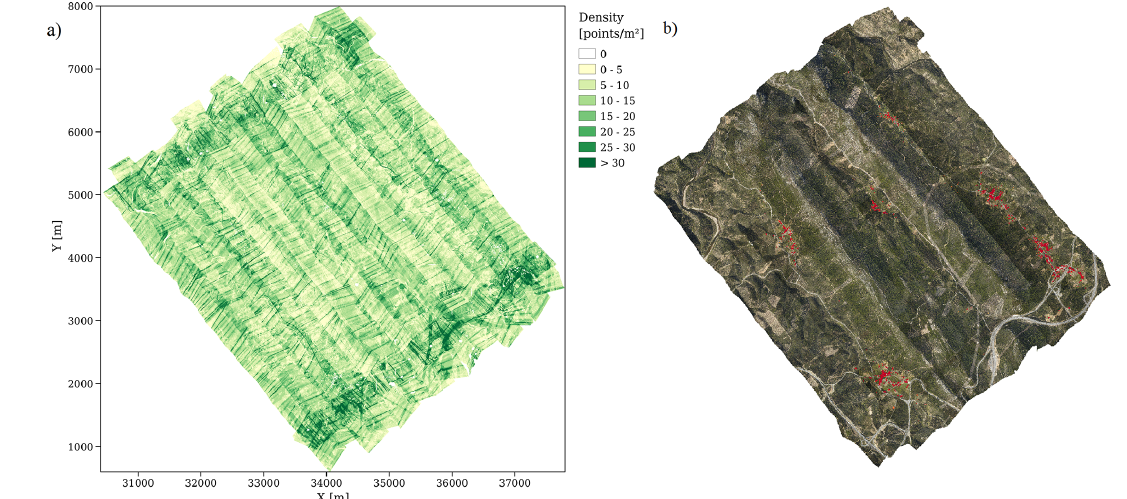
Figure 1. Lidar aerial survey and orthophoto: (a) ground -class point distribution; (b) orthophoto (houses in red).